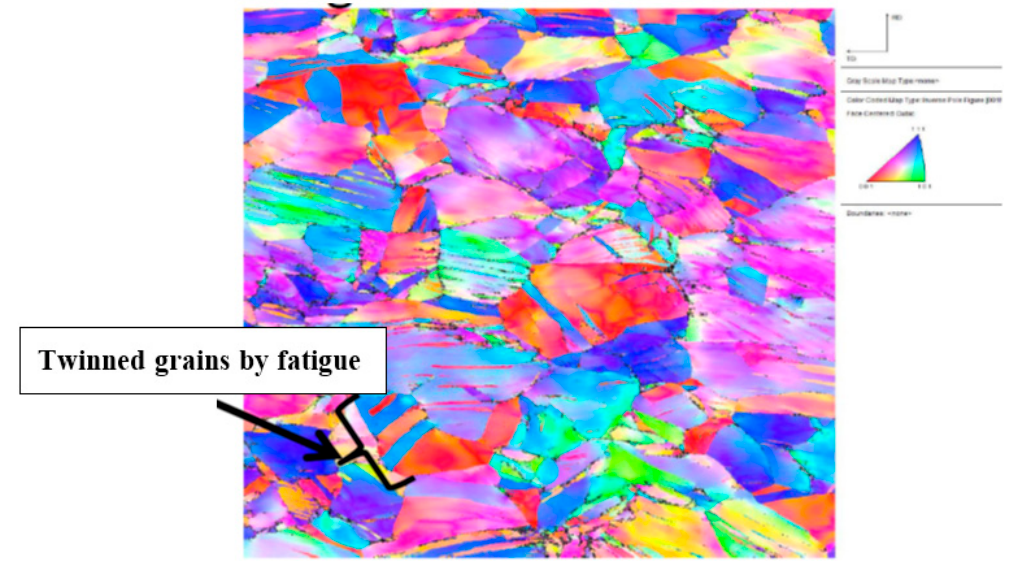
Figure 10. Inverse pole figure showing crystallographic characterization of the plate microstructure showing twinning that may have occurred due to in vivo use by fatigue or a material feature.